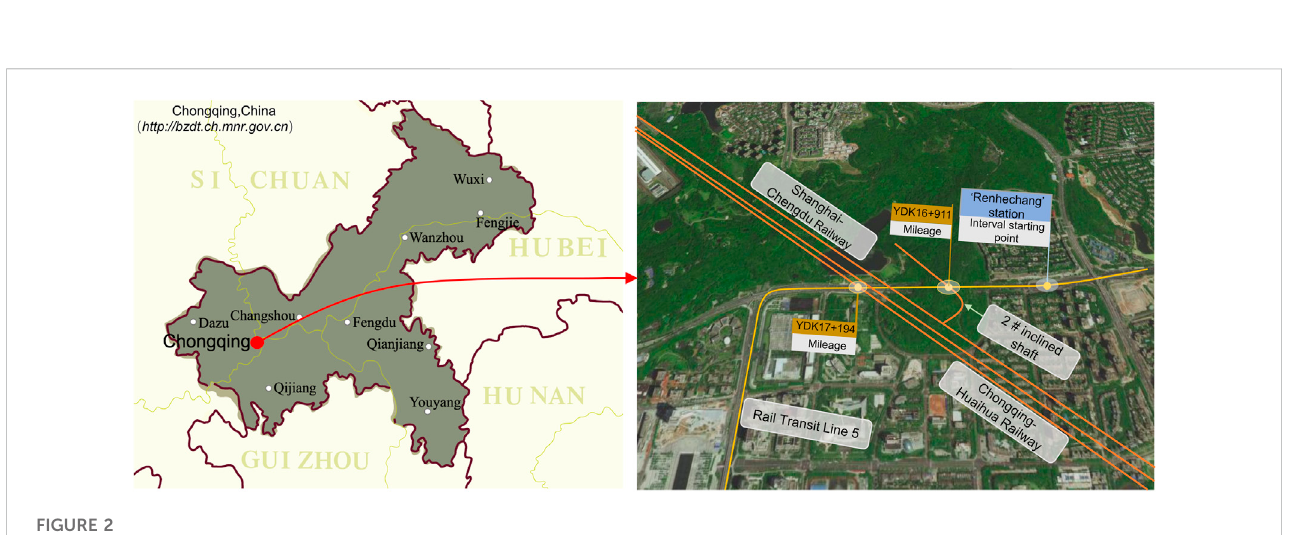
Location plan of the adjacent